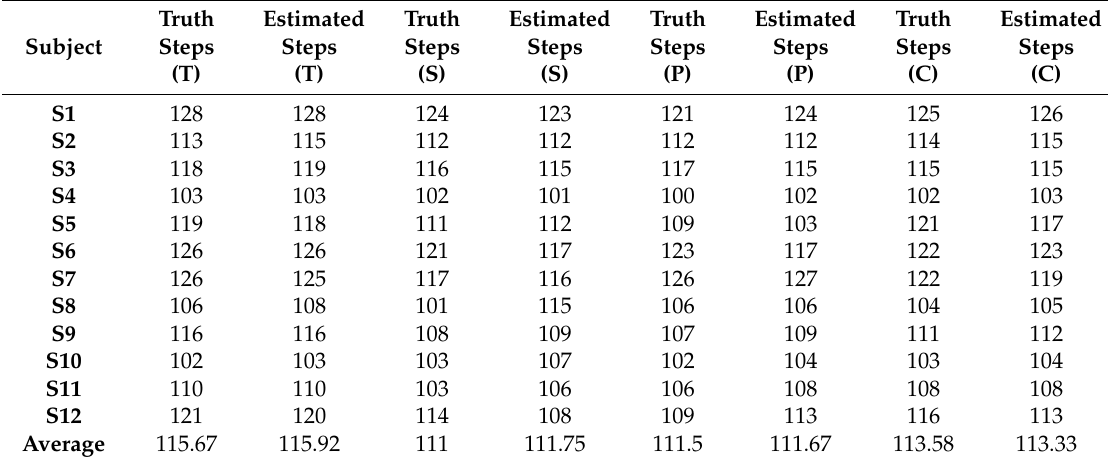
Table 5. Metrics for evaluating the adaptive step detection method with different pose.